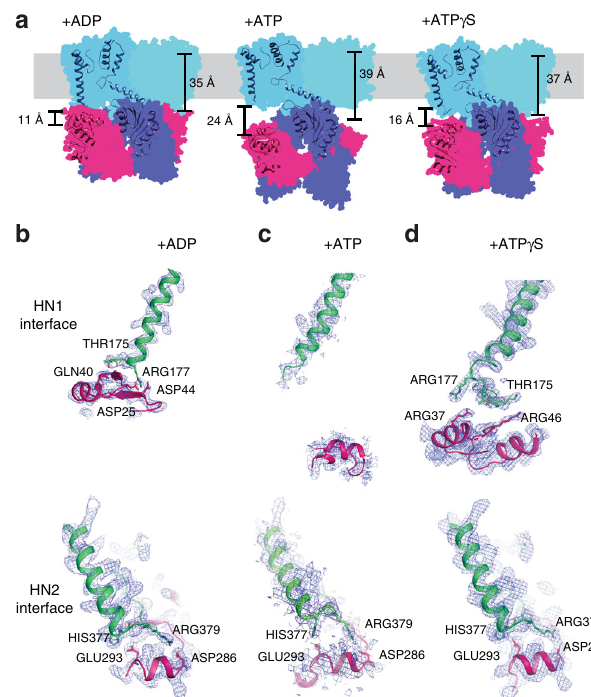
Fig. 4 The TrkH-TrkA interfaces. a TrkH-TrkA interactions. TrkHA-ADP (left), TrkHA γ S (center), or TrkHA-ATP (right) are shown in colored schematics, viewed within the plane of the membrane. Structural elements involved in TrkH-TrkA interactions are shown as cartoon. Distances from TrkH ILE178 to TrkA ASP25 are marked on the left side of each complex. Distances from the TrkH selectivity fi lter to TrkH-TrkA-N2 interface (GLY222 to SER389) are marked on the right side. b – d Top: the HN1 interfaces from TrkHA-ADP ( a ), TrkHA-ATP ( b ), or TrkHA-ATP γ S ( c ). Bottom: the HN2 interfaces from TrkHA-ADP ( a ), TrkHA-ATP ( b ), or TrkHA-ATP γ S ( c ). TrkH (green) and TrkA (hot pink) are shown as cartoon. The 2Fo-Fc electron density maps are shown as blue meshes at 1.0 σ